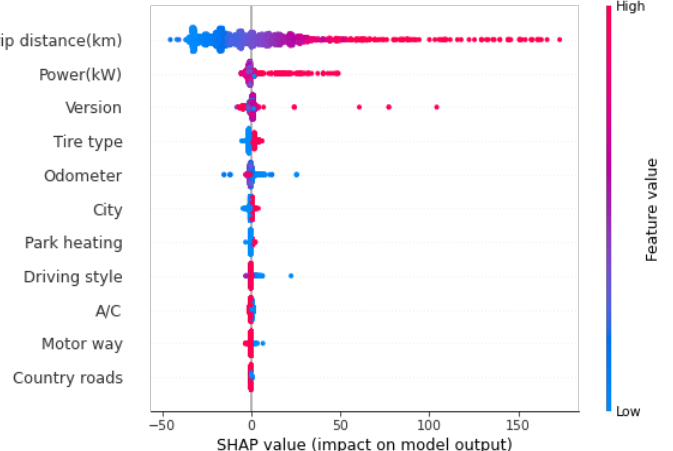
Figure 5. SHAP summary of the relative importance of various features used in the prediction of total energy consumption of the EVs. total energy consumption of the EVs.